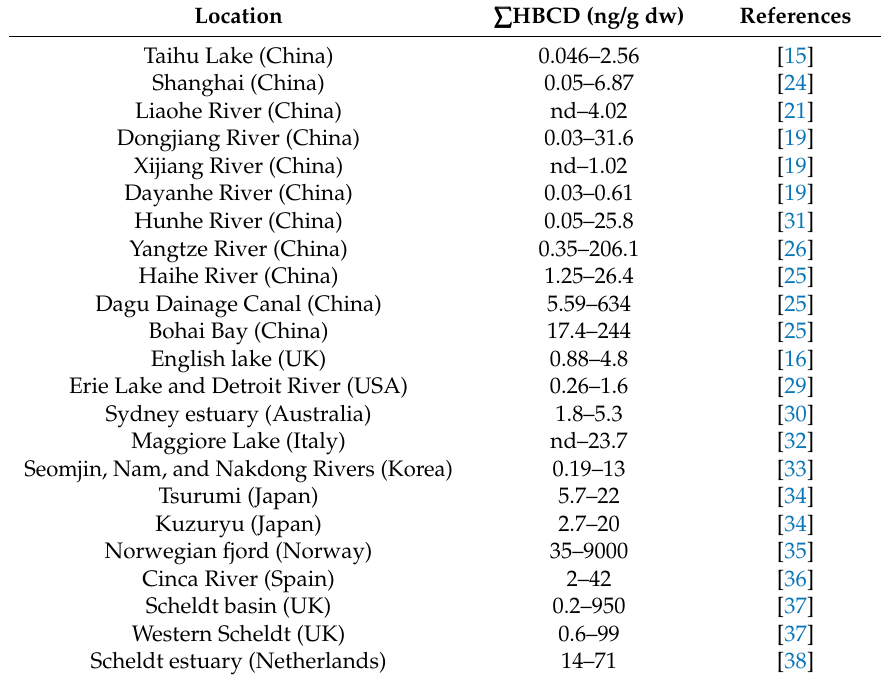
Table 2. Comparison of HBCD concentrations in sediment samples among different